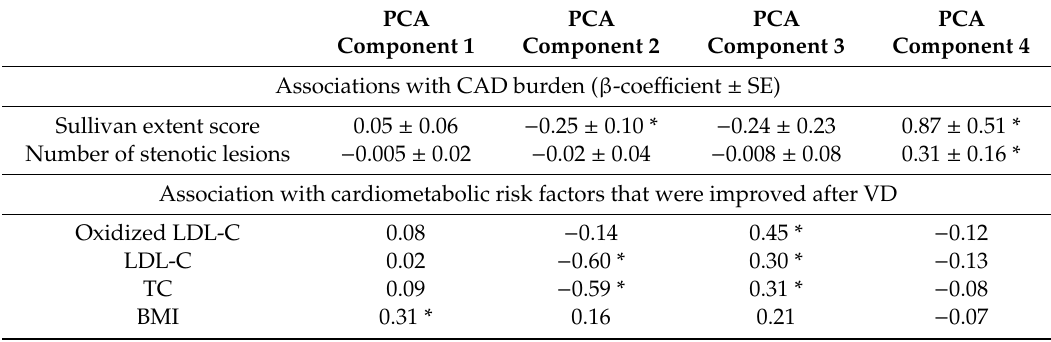
Table 2. Associations between of orthogonal lipids pattern described by principal components derived from a principal component analysis with coronary artery disease burden and cardiometabolic risk factors.